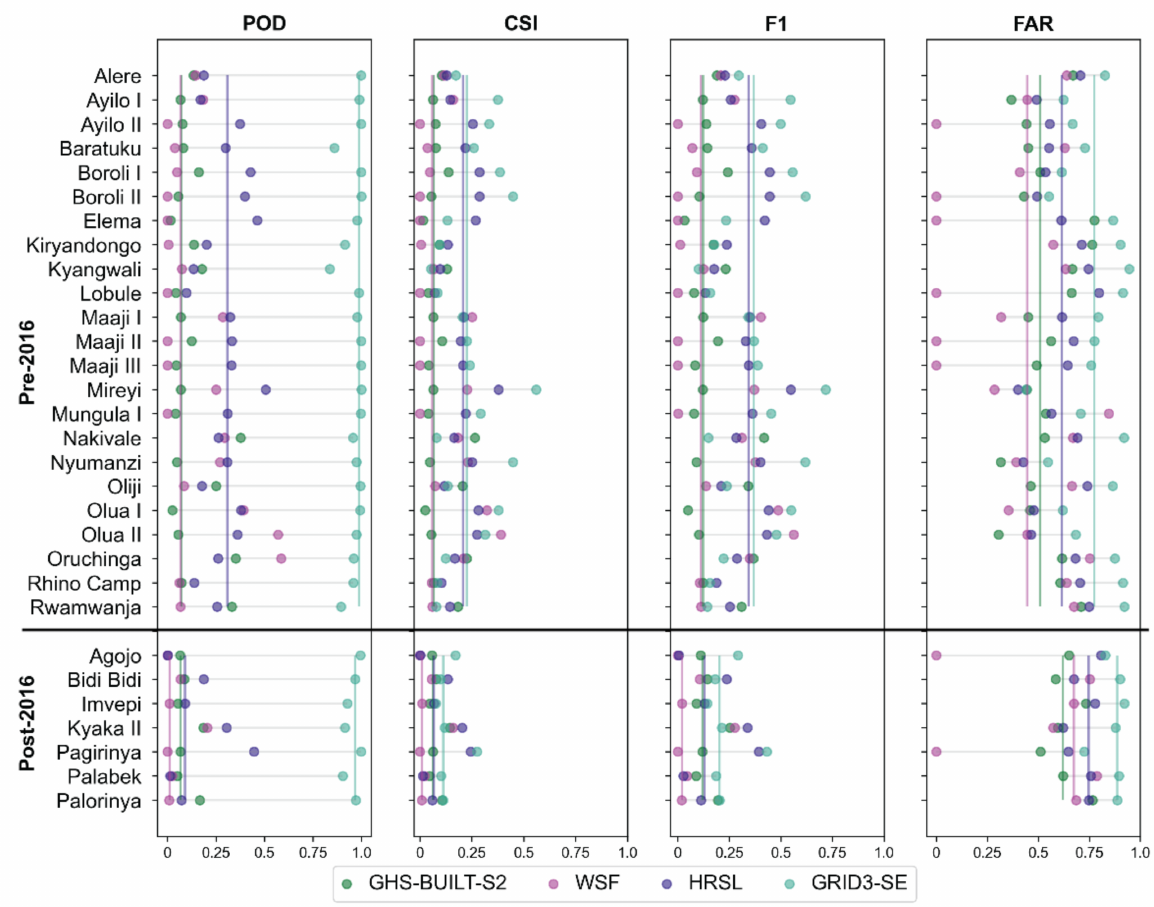
Figure A1. Lollipop plots of human settlement product detection metrics across all refugee settlements. Vertical colored lines correspond to the median values of each product’s relative coverage for pre- and post-2016 settlements. GHS-BUILT-S2, Global Human Settlement Layer with Sentinel 2; WSF, World Settlement Footprint; HRSL, High Resolution Settlement Layer; GRID3-SE, Geo-Referenced Infrastructure and Demographic Data for Development settlement extent data; POD, probability of detection; CSI, critical success index; F1, F1-score; FAR, false alarm